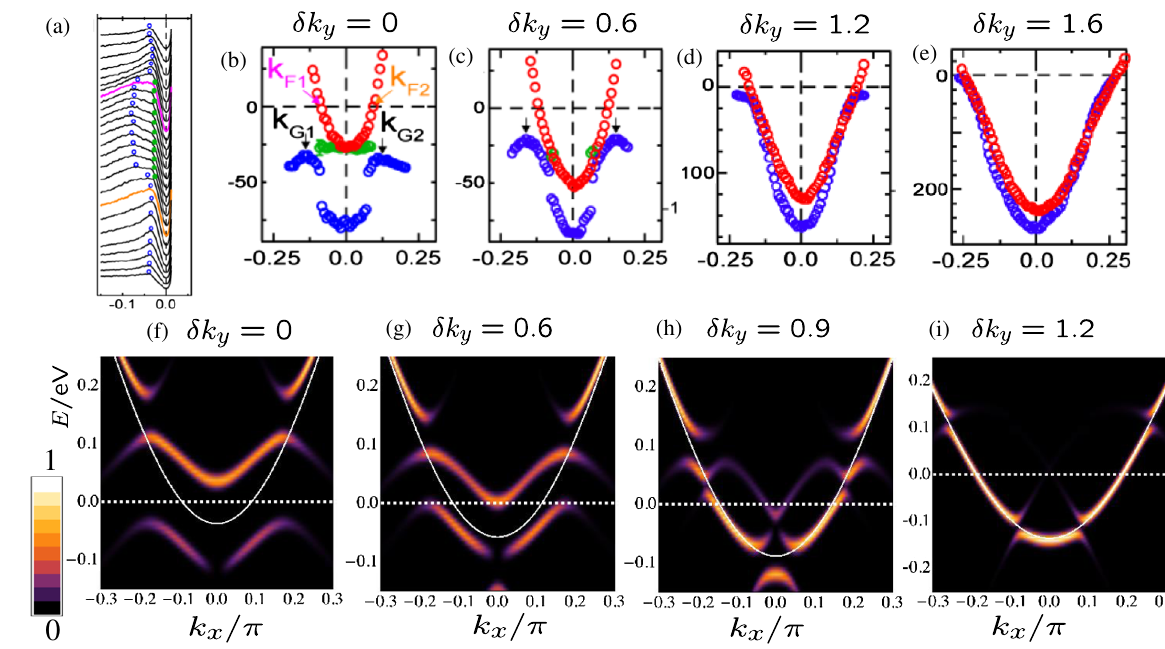
FIG. 3. ARPES spectra from Ref. [12] for scans with approximately constant k y ¼ π − δ k y , where δ k y ≈ 0 ; 0 . 6 ; 1 . 2 , and 1.6. Raw data for δ k y ¼ 0 are shown in (a). The Fermi arc begins near δ k y ¼ 1 . 2 . The Amperean pairing spectra are shown ( f − i ) for δ k y ¼ 0 ; 0 . 6 ; 0 . 9 , and 1.2 using Δ 0 ¼ 75 meV and k 0 ¼ 1 . The white line shows the band before pairing. With these parameters, the gap closes and the Fermi arc begins near δ k y ¼ 0 . 6 . The negative energy states are to be compared with the data. In (f), we note that the minimum excitation energy to the Fermi level does not lie at k F but at a larger wave vector. This feature has been noted by the experimentalists, who introduced the wave vector k G in their figures (b) and (c) to describe this. The green dots in (b) appear only below T c , and the blue dots at the band bottom mark the peak of a very broad spectrum near 100 meV as seen in (a). The red dots in (b) – (e) are data taken above the pseudogap